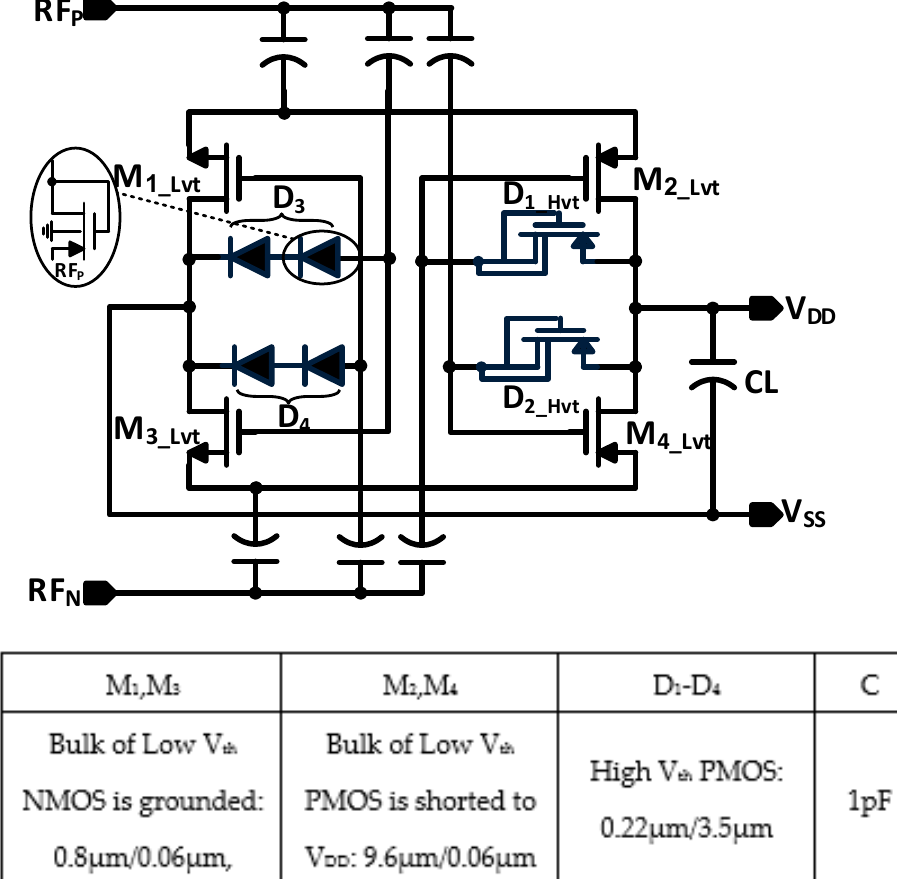
Figure 3. Proposed RF rectifier with adaptive biasing technique.